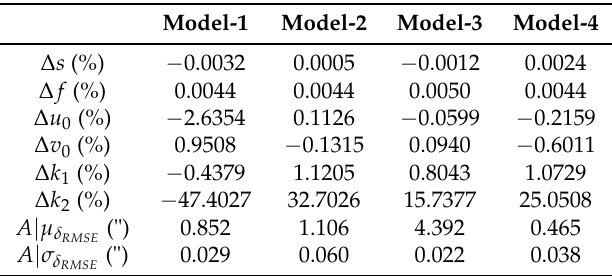
Table 2. Calibration results by different